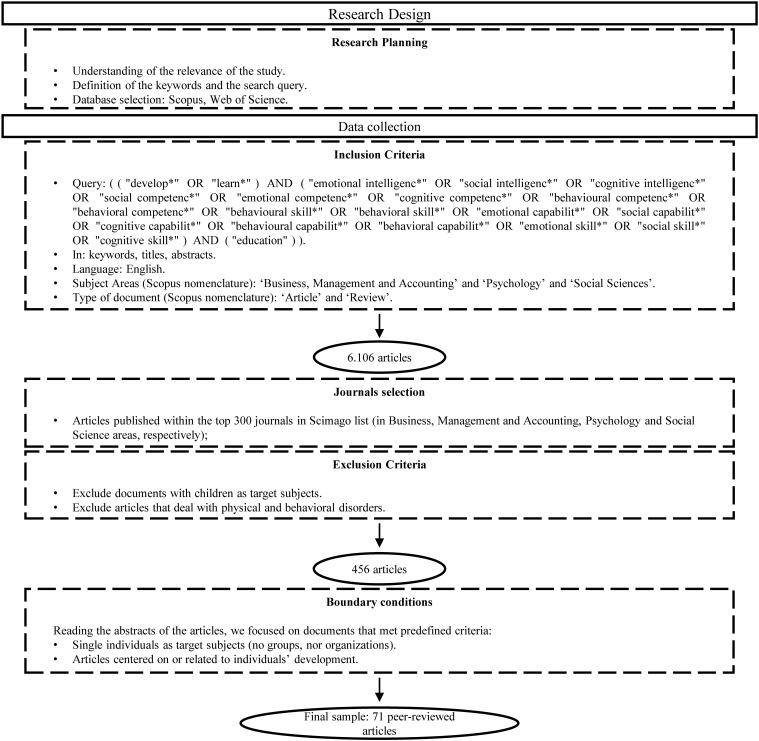
Research design.